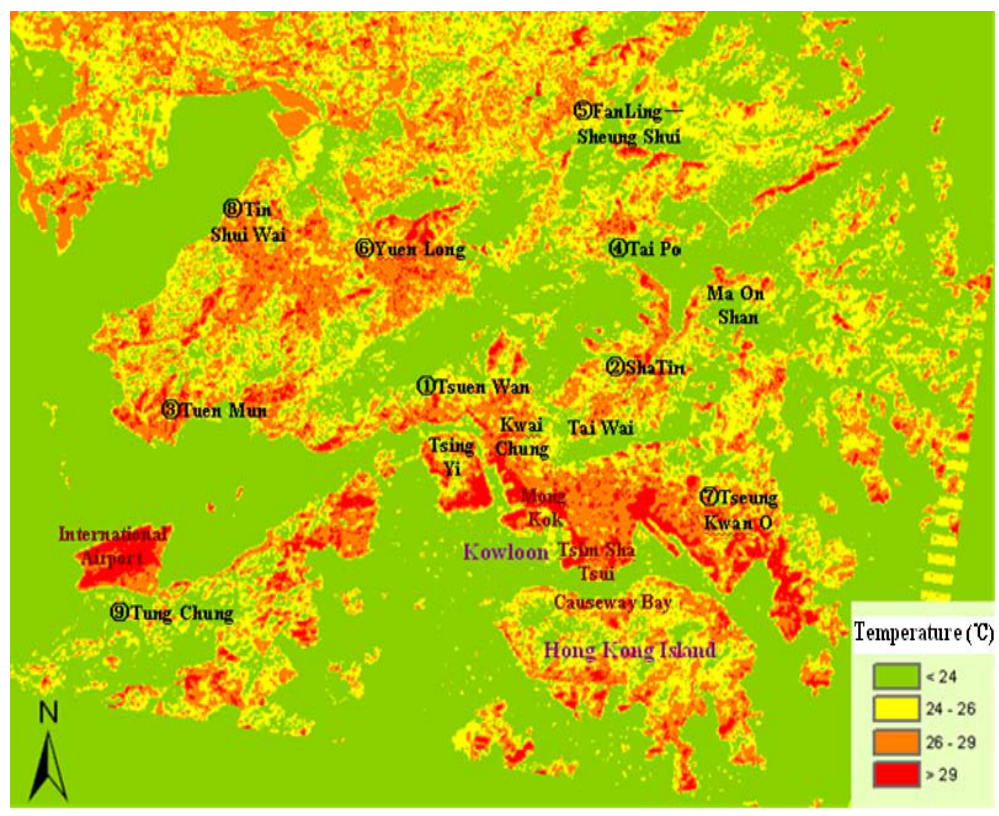
Figure 7. The LST distribution in Hong Kong in